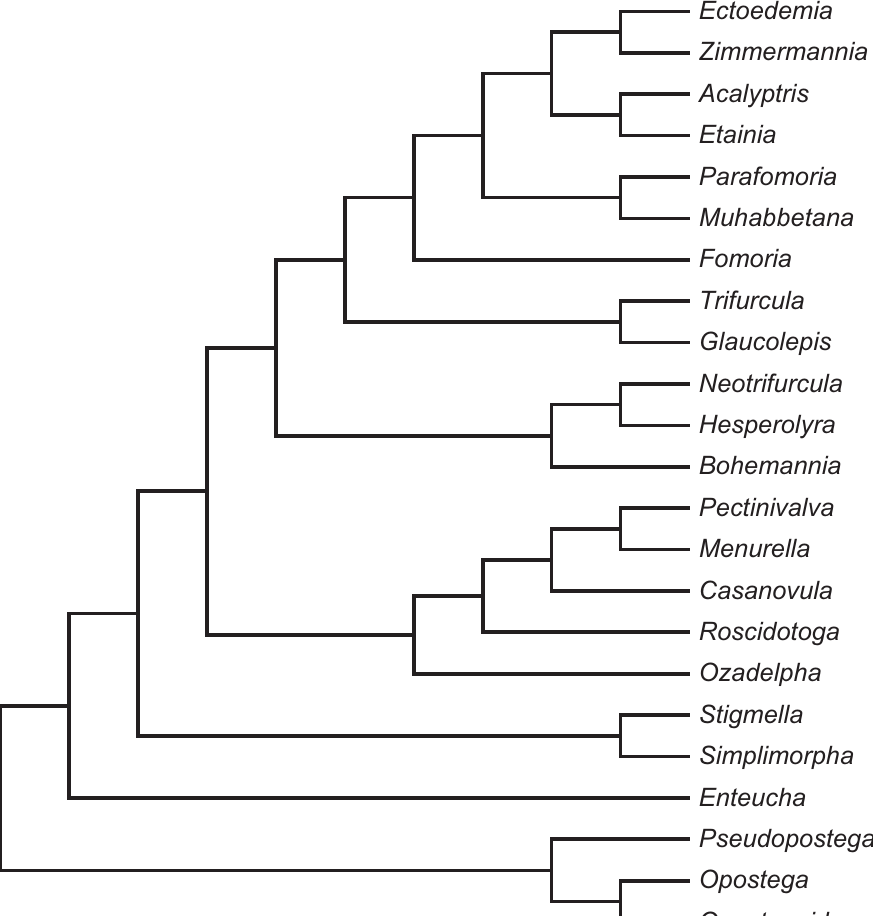
Figure 24A. Schematic phylogram of Nepticulidae genera based on the best resolved tree of our Molecular phylogeny (Doorenweerd et al.